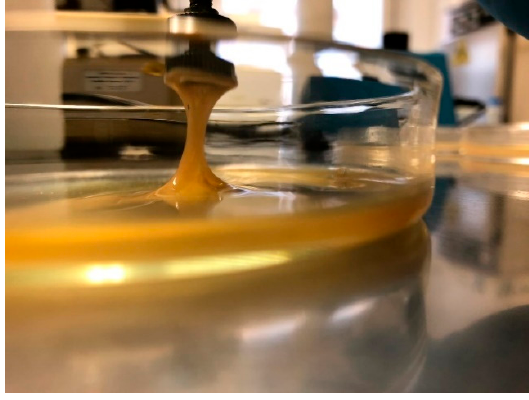
Figure 5. Biofilm appearance after 48 h of incubation.